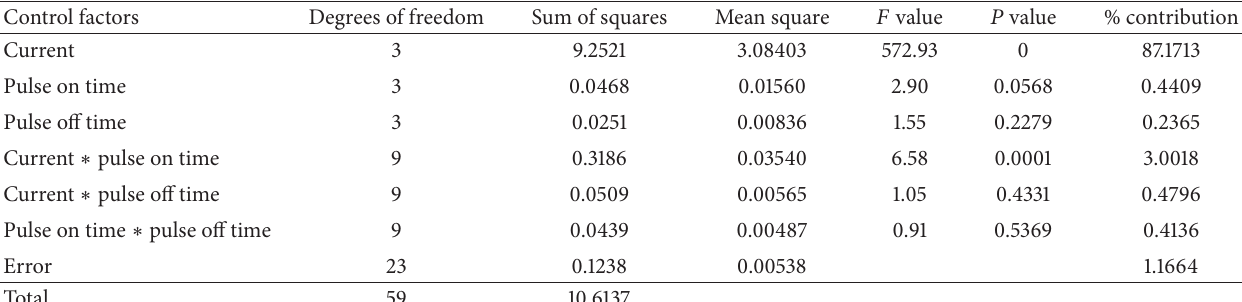
Table 3: ANOVA for Ra.